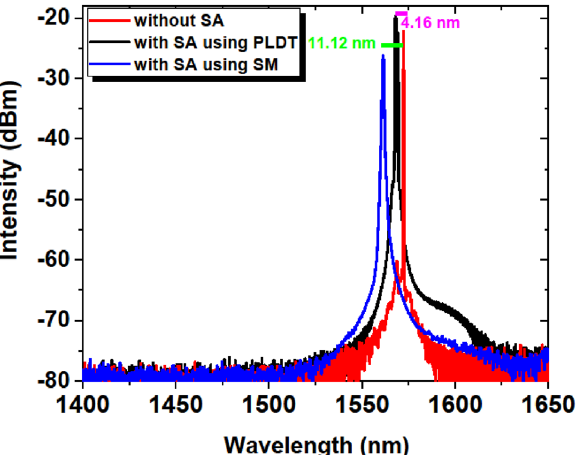
Figure 7. Measured optical spectrum of EDFL without SA (solid red line) and for SA prepared using SM (solid blue line) and PLDT (solid black